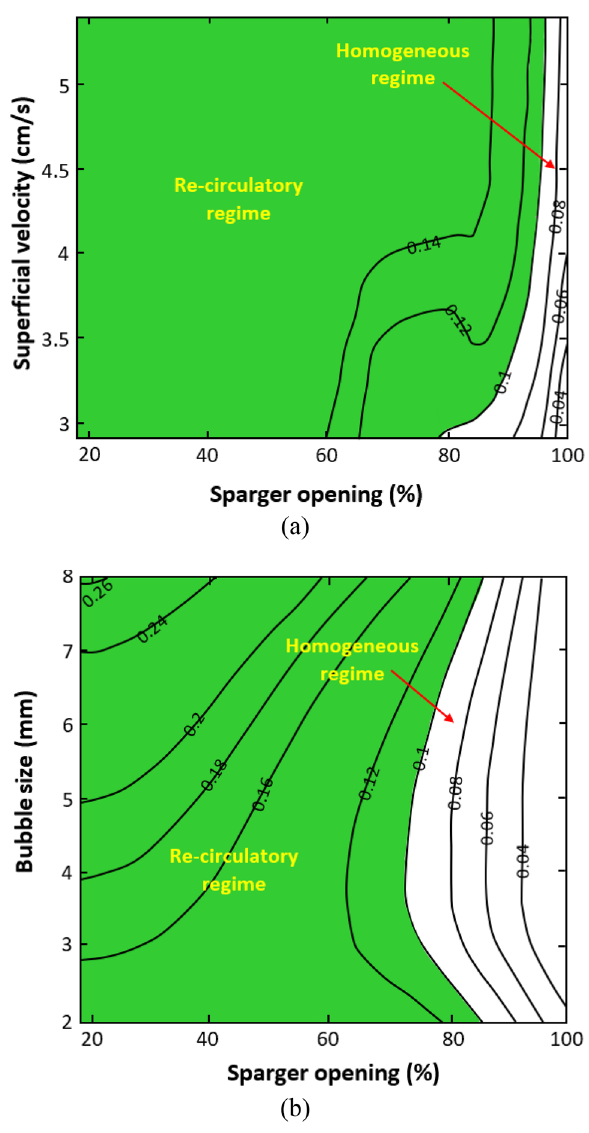
Fig. 17 Flow regime map for a gas superficial velocity–sparger opening and b bubble size–sparger